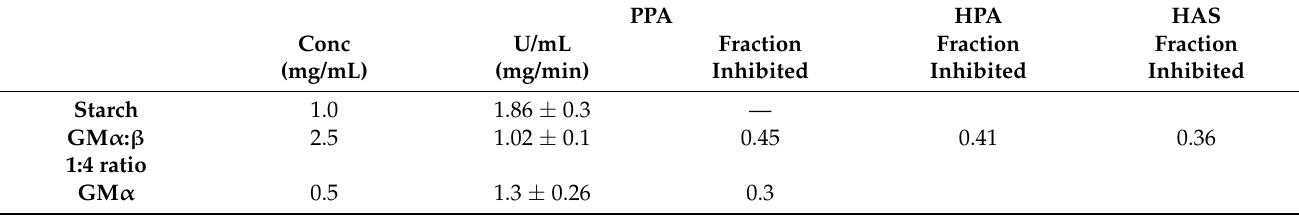
Table 1. Rates of α -amylase-mediated hydrolysis of starch as measured by the starch–iodine assay and MT2/MT3 resonance intensity using NMR. Amylase-inhibitory potential to assess the effectiveness of GM α and GM β on starch hydrolysis was performed essentially according to the protocol of Xiao et al. [21]. Although most assays were performed using porcine pancreatic α -amylase (PPA), a few were done using human pancreatic α -amylase (HPA), and human salivary α -amylase (HSA). A total of 100 µ L of 1 mg/mL (or 5 mg/mL) of soluble starch ± various concentrations (0.5 mg/mL up to 16 mg/mL) of GM α or GM β were incubated for 20 min at 30 ◦ C ± 5 µ L enzyme, for a total concentration of 1 µ M amylase/well. The assay was also performed with 400 µ M acarbose. At the end of the reaction, the absorbance was read at 562 nm. Assays were performed at 0.5, 1, 2, and 4 mg/mL, Acarbose at 400 µ M, and starch at 1 mg/mL or 5 mg/mL. U/mL = (A 562 control − A 562 sample)/(A 562 starch × 20 minutes × 0.1 mL reaction volume), and is interpreted to indicate X. U/mL values shown are averages of 4 or 5 separate experiments each done in triplicate. PPA HPA HAS Conc U/mL Fraction Fraction Fraction (mg/mL) (mg/min) Inhibited Inhibited Inhibited Starch 1.0 1.86 ± 0.3 — GM α : β 2.5 1.02 ± 0.1 0.45 0.41 0.36 1:4 ratio GM α 0.5